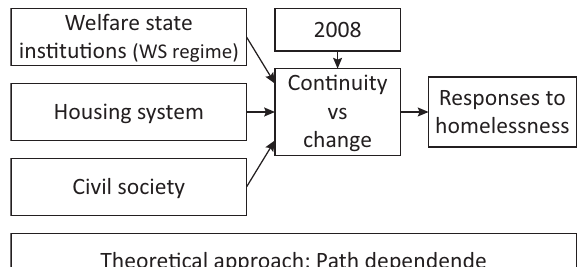
Figure 2. Institutional structures influencing homeless- ness policy change (source: